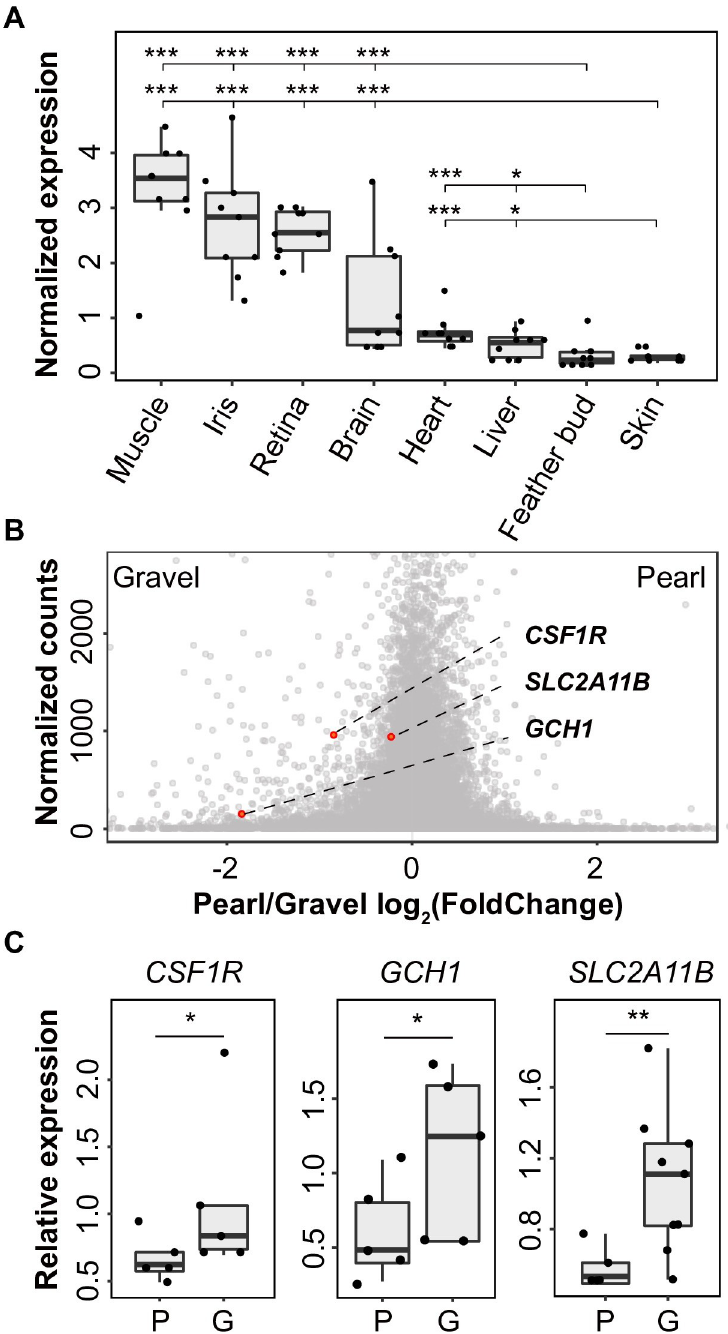
Fig 4. The expression profile of SLC2A11B in pigeon tissues and genes with differential expression between pearl and gravel irises. (A) Normalized expression of SLC2A11B in various tissues from wild-type pigeons as determined by qPCR analysis. Boxes span the first to third quartiles, bars extend to the minimum and maximum observed values, black lines indicate the medians, and circles represent the data points. (B) Normalized comparison of SLC2A11B expression between the pearl and gravel irises by transcriptome sequencing. Differentially expressed genes involved in xanthophore differentiation or pteridine synthesis are highlighted. (C) qPCR validation of differentially expressed genes ( CSF1R , GCH1 , and SLC2A11B ) between pearl and gravel irises. � P < 0.05, �� P < 0.01, ��� P < 0.001.